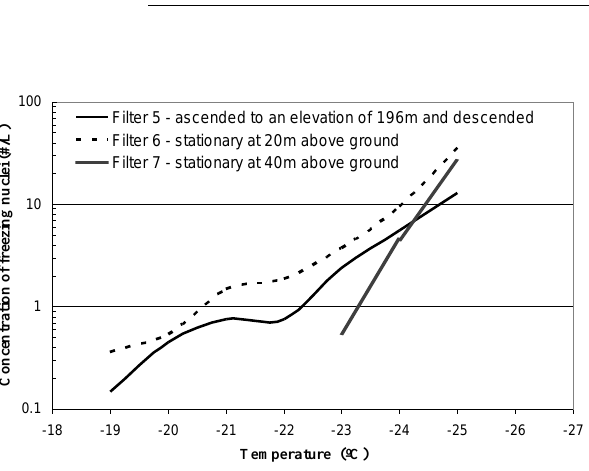
Fig. 6: Concentrations of Freezing Nuclei at different temperatures for the rooftop measurements on different days of the campaign. Each day is represented by a different symbol, and each temperature is represented by a different color.